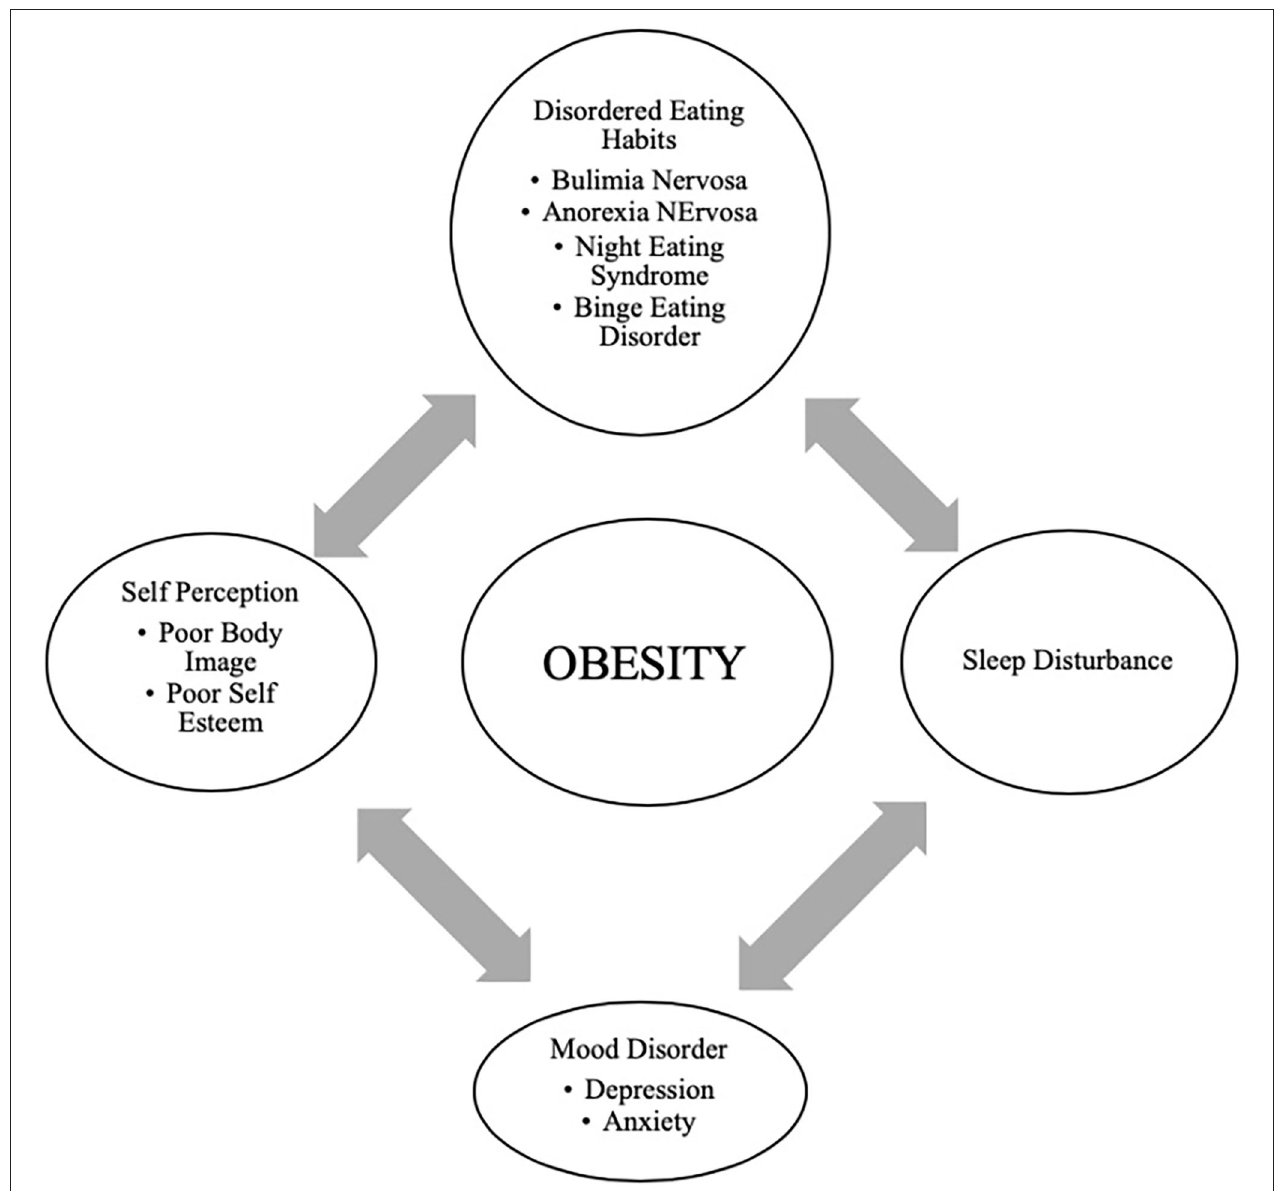
FIGURE 4 | Bidirectional relationship of different psychological outcomes of